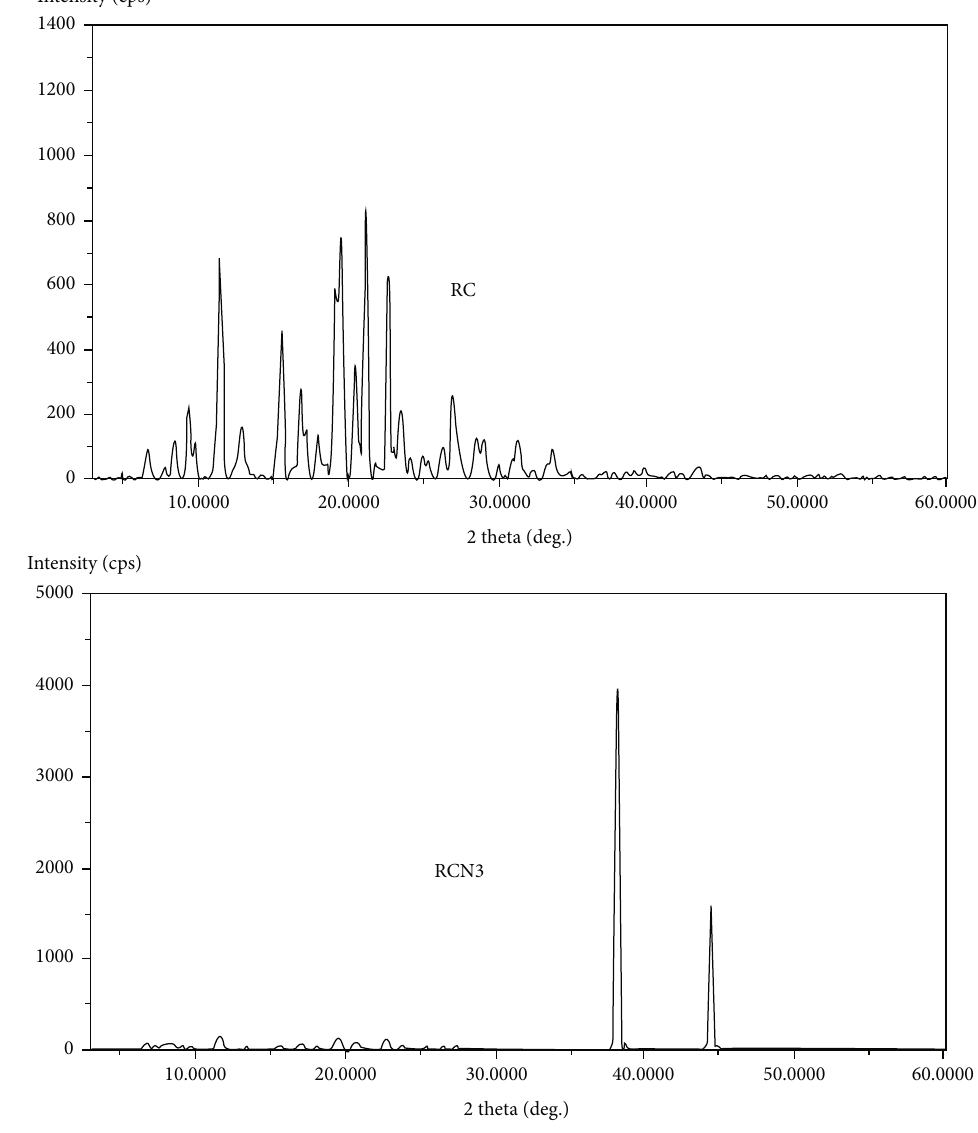
Figure 3: Comparative XRD pattern of pure RC and optimized nanosponge